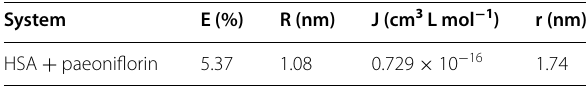
Fig. 8 Spectral overlap of fluorescence of HSA solution and absorption of paeoniflorin solutions ([HSA] [paeoni‑ = florin] 1.0 10 − 5 mol L − 1 , T 288 K) = × = Table 2 Energy transfer efficiency (E), critical binding distance (R), overlap integral (J) and binding distance (r) calculated according to Föster’s non-radioactive energy transfer